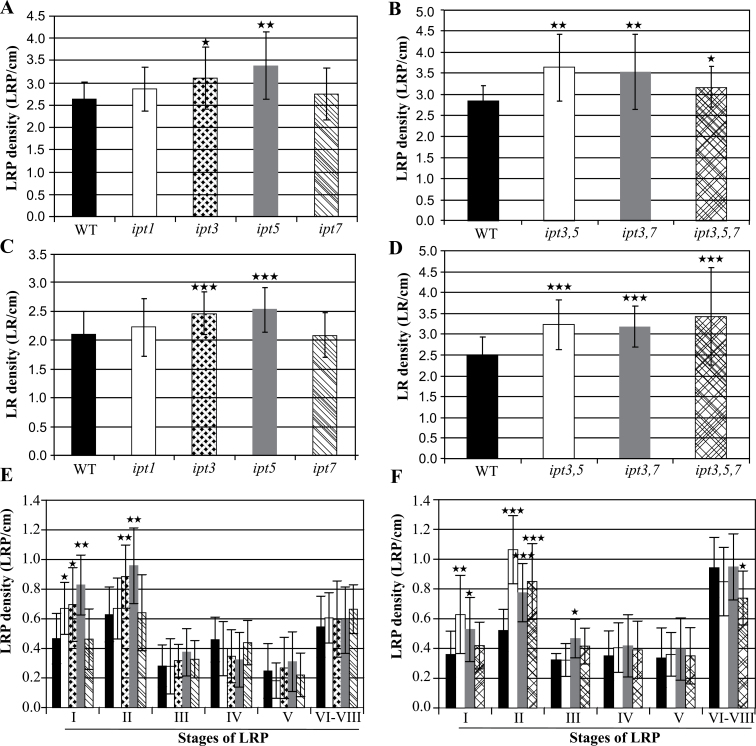
LR formation in ipt mutant seedlings. LRP (A) and LR (C) density of single ipt gene mutants. LRP (B) and LR (D) density of different ipt double and triple mutants. (E, F) LRPs of different stages formed on the primary roots of ipt transgenic seedlings compared with wild-type seedlings. The filling of bars corresponds in (E) to the same genotypes as in (A) and (C), and in (F) to the same genotypes as in (B) and (D). The number of LRPs and emerged LRs was counted 10 d after germination. The values shown are means ±SD. n ≥15. Significance of differences was analysed by Student’s t-test. *P < 0.05; **P < 0.01; ***P < 0.001.